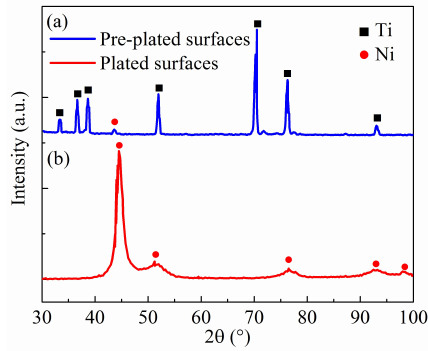
Figure 5. X-ray diffractometer (XRD) patterns of the ( a ) pre-plated and ( b ) plated surfaces via electro-brush plating.